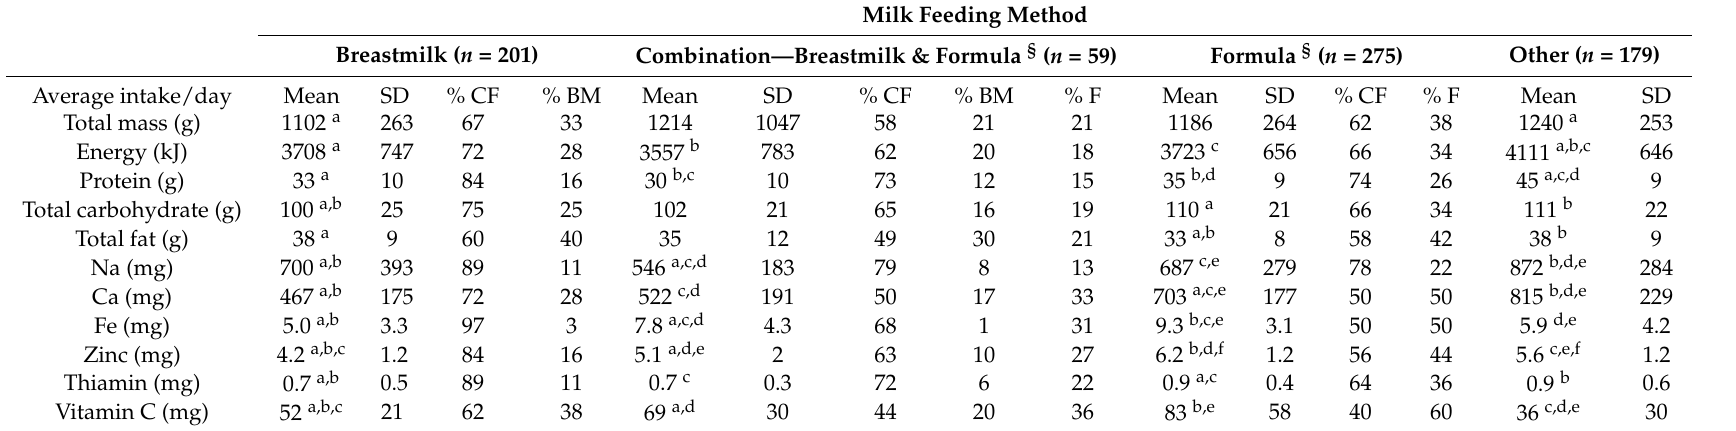
Table 3. Comparison of the mean nutrient intakes of children ‡ by milk feeding